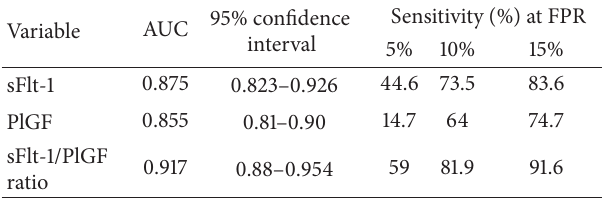
Figure 2: Median and interquartile range of placental growth factor in case group, 97 (29) and in control group, 186 (57.5); 𝑃 < 0.0001 .